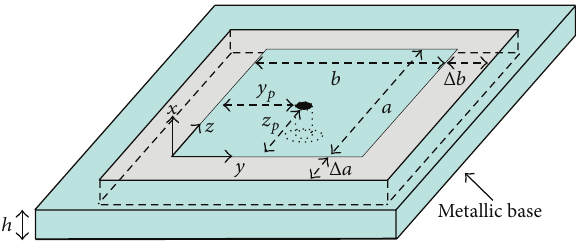
Figure 1: Cavity-backed rectangular-patch microstrip antenna.